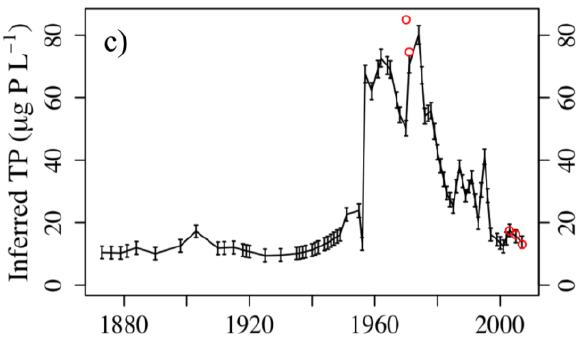
Fig. B1. Temporal changes of (TP) as reconstructed from the diatom-transfer functions (Inferred TP (continuous line, left axis), and measured water (TP) (red open circles, right axis)) in Lake Bourget.